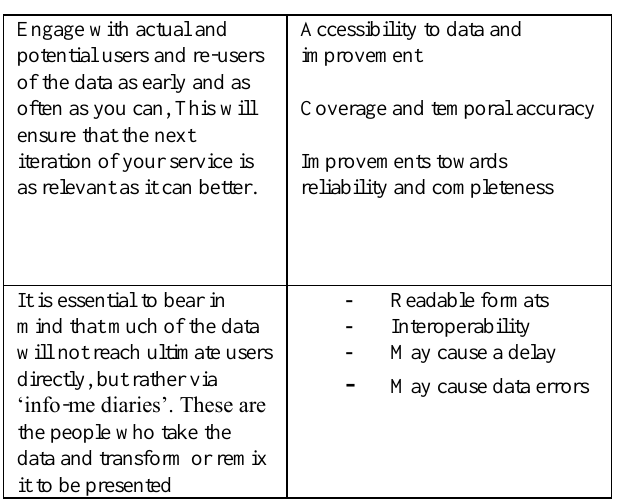
Table 2. More rules of OGD working group